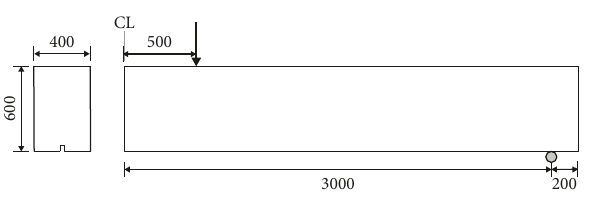
Figure 14: Test setup (in mm).